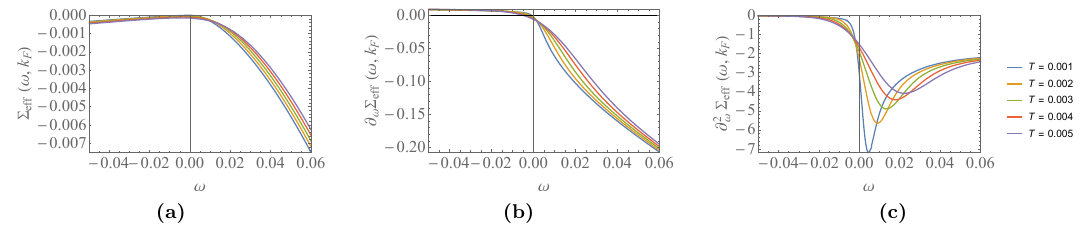
Figure 13 . (a) The e(cid:11)ective self-energy (cid:6) e(cid:11) at the Fermi momentum, and its (b) (cid:12)rst and (c) second derivatives. The legend on the right of (c) holds for all (cid:12)gures. In all graphs, (cid:22) = 2, g = 1 and (cid:21) =